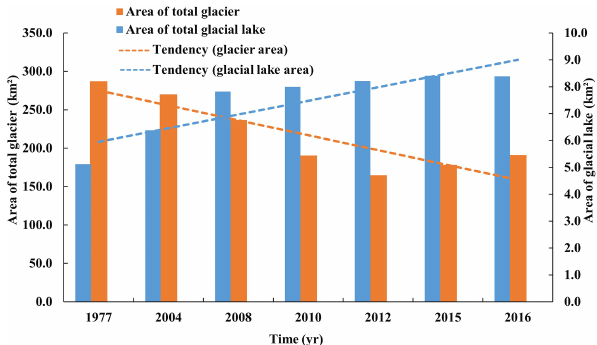
Figure 7. Area changes in the five typical glacial lakes and